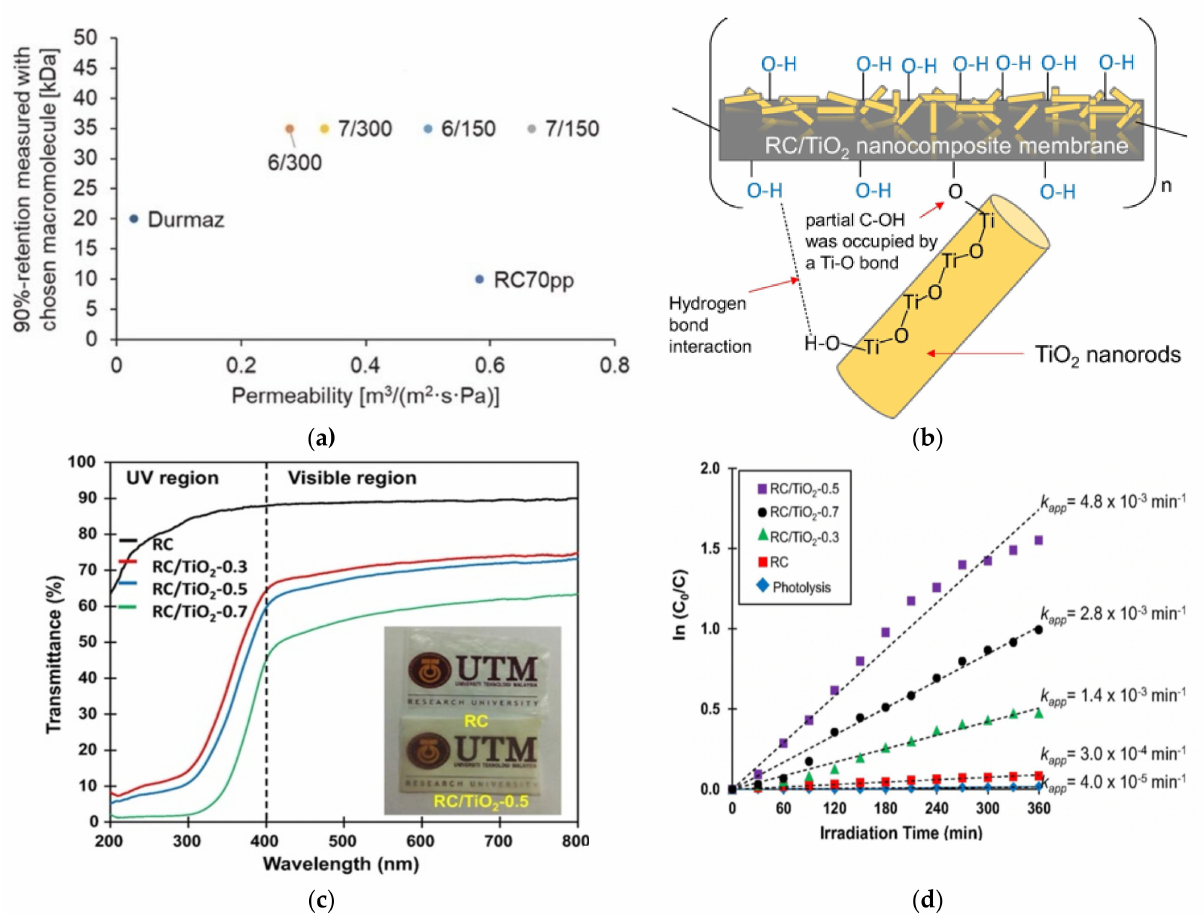
Figure 4. ( a ) Permeability and the retention values of cellulose membranes prepared from waste cotton textile, commercial CA membrane (RC70pp), and cellulose membrane from commercial source (Durmaz) (Sample n/m, n: cellulose wt% m: polymer thickness in µ m) [141]. ( b ) Schematic illustration of hydrogen bonding between recycled cellulose and TiO 2 nanorods, ( c ) optical properties of TiO 2 nanorods incorporated cellulose photocatalytic membranes, and ( d ) kinetic profile of cellulose photocatalytic membranes incorporated with difference concentration of TiO 2 nanorods under visible light irradiation